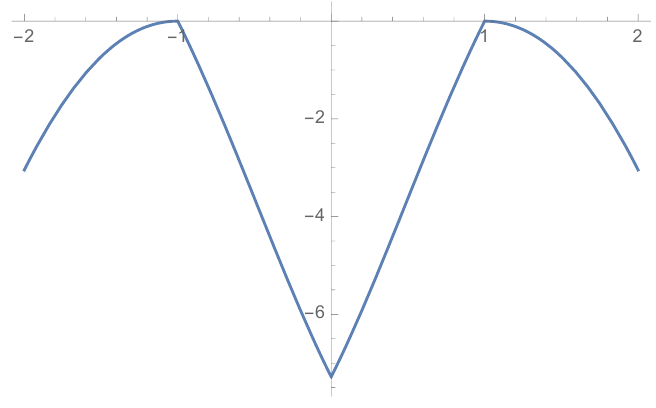
Figure 6 . The order b (cid:0) 2 piece of log S 1